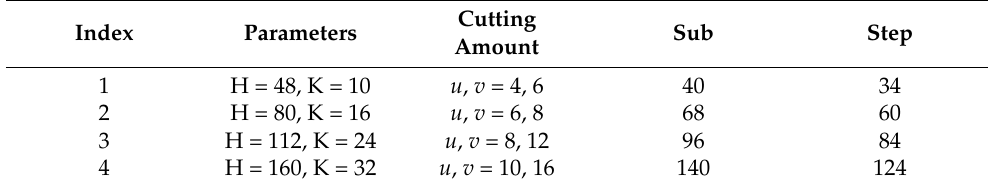
Table 3. Parameters in four groups.